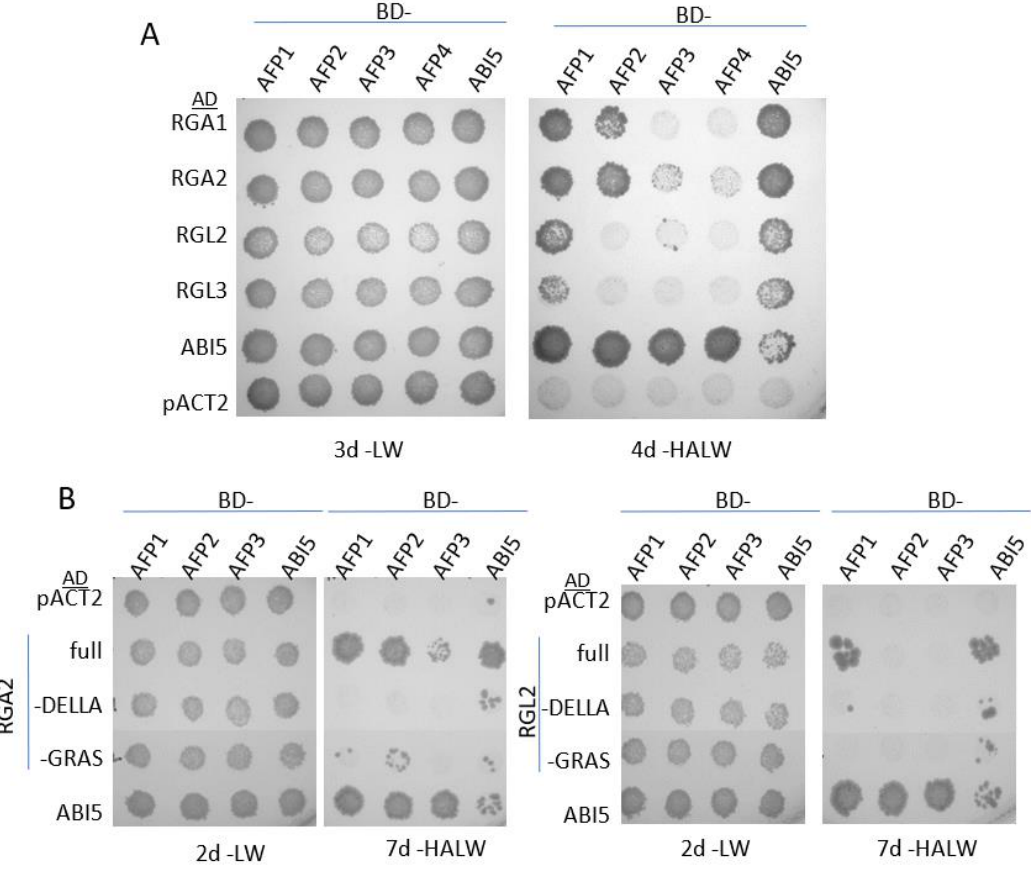
Figure 1. Yeast two-hybrid interactions between AFPs and DELLAs. ( A ) Interactions between the GAL4 AD alone (pACT2) or fusions to the DELLAs or ABI5 and GAL4 BD- fusions to AFPs or ABI5. ( B ) Mapping domains of RGA2 or RGL2 required for interaction with the AFPs or ABI5. Growth on -LW selects for diploids carrying both AD- and BD-fusions. Growth on -HALW requires interaction to produce GAL4-dependent activation of the HIS and ADE reporters.